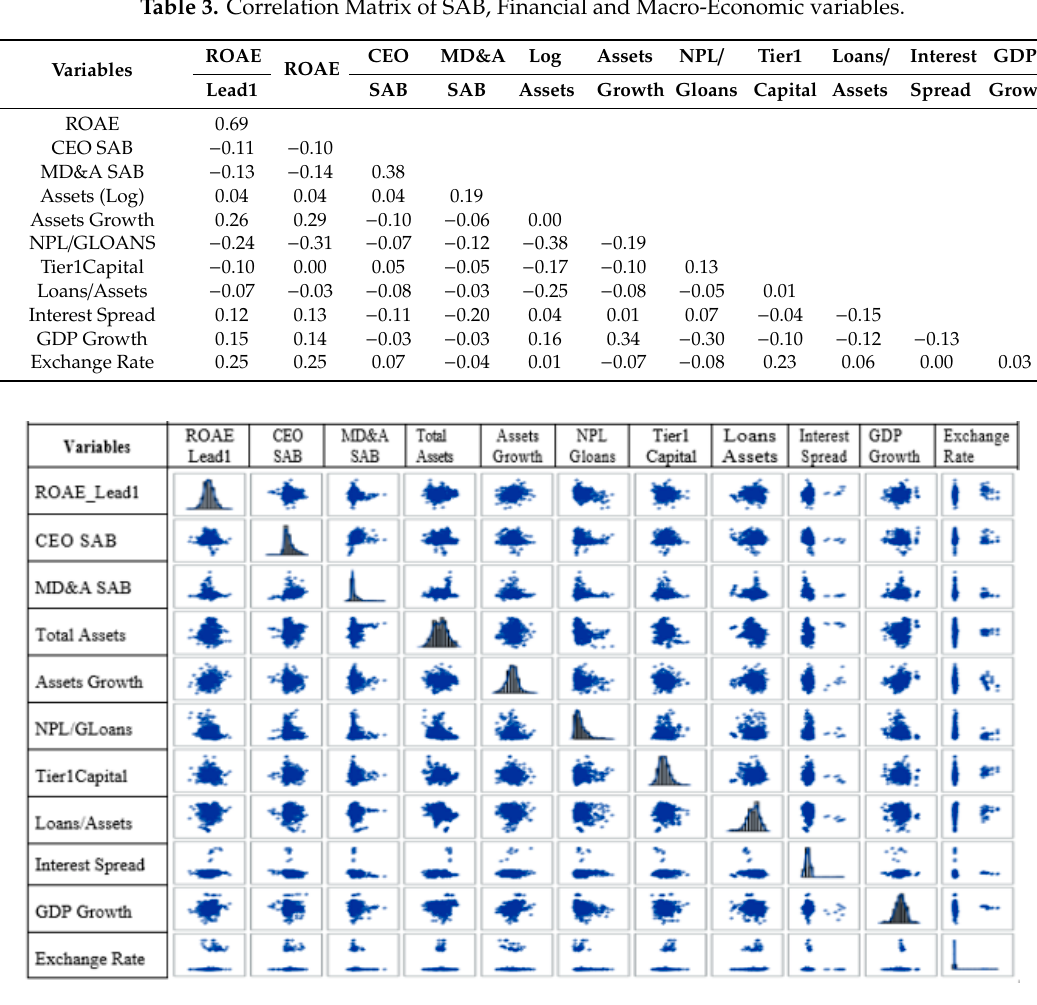
Figure 2. Scatter Plot Matrix of Independent and Dependent Variables.